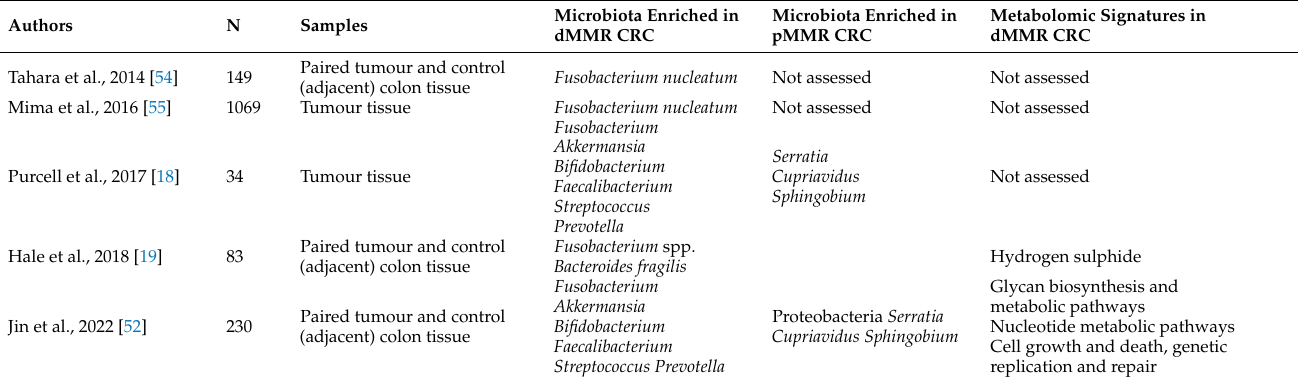
Table 2. Microbiome and metabolomic signature differences in dMMR and pMMR